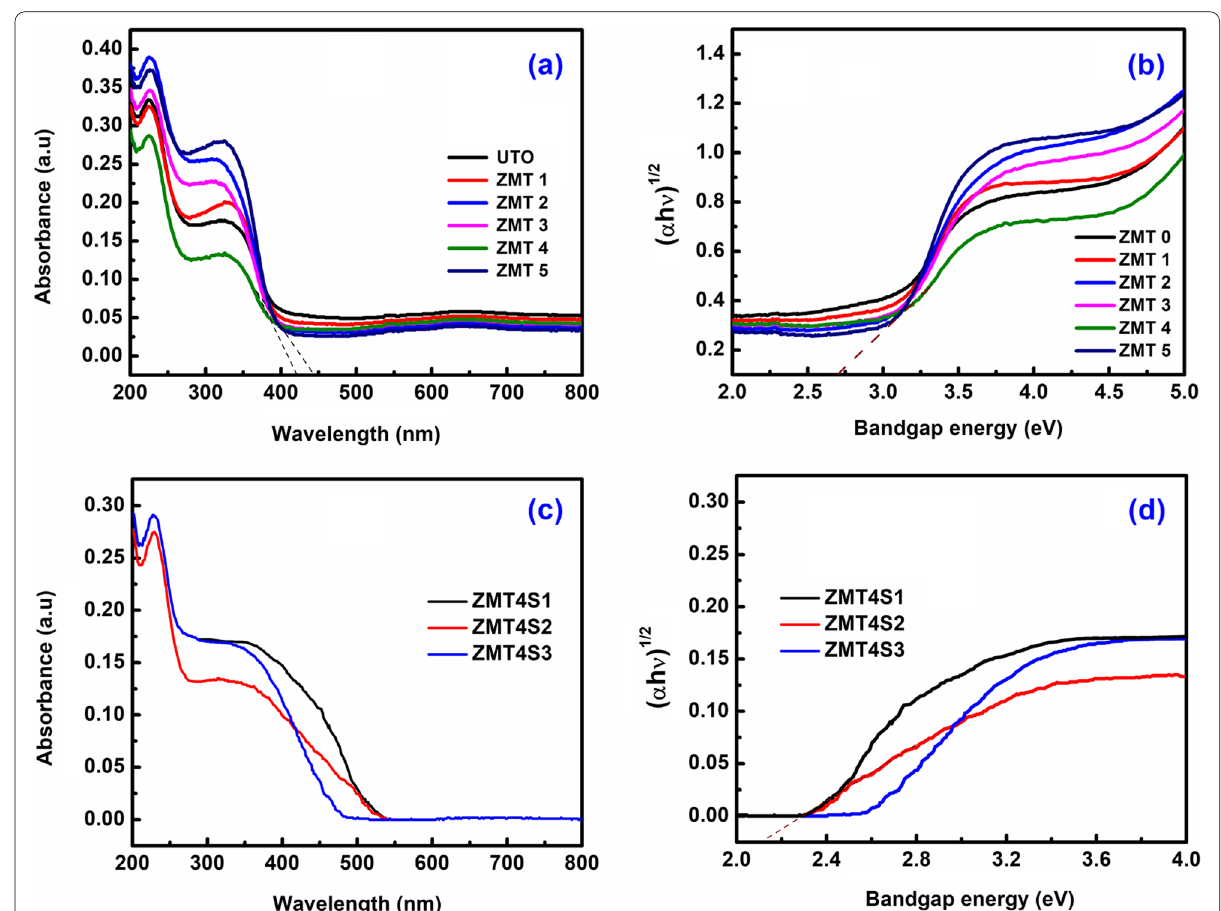
Fig. 7 a, c The DRS spectra and b, d tauc plot of undoped and Zn/Mg co-doped TiO 2 without surfactant and with surfactant respectively